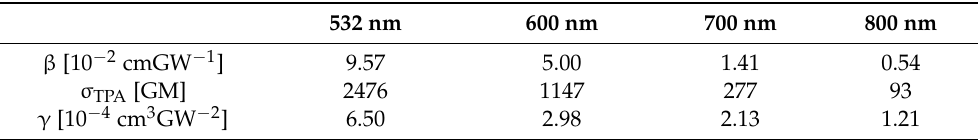
Table 1. The parameters of TPA and TPA induced ESA of PyDN under selected wavelengths achieved from Z-scan